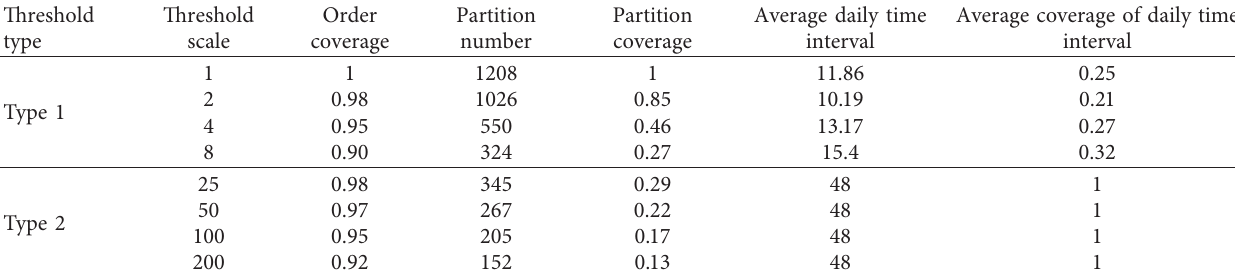
Table 1: Order data characteristics under different minimum threshold settings.